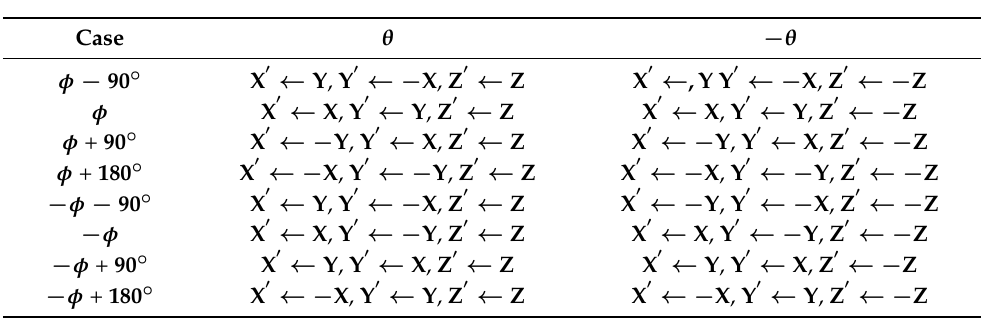
Table 1. Sixteen cases of spatial augmentation. The channel W carrying omnidirectional information does not change during the